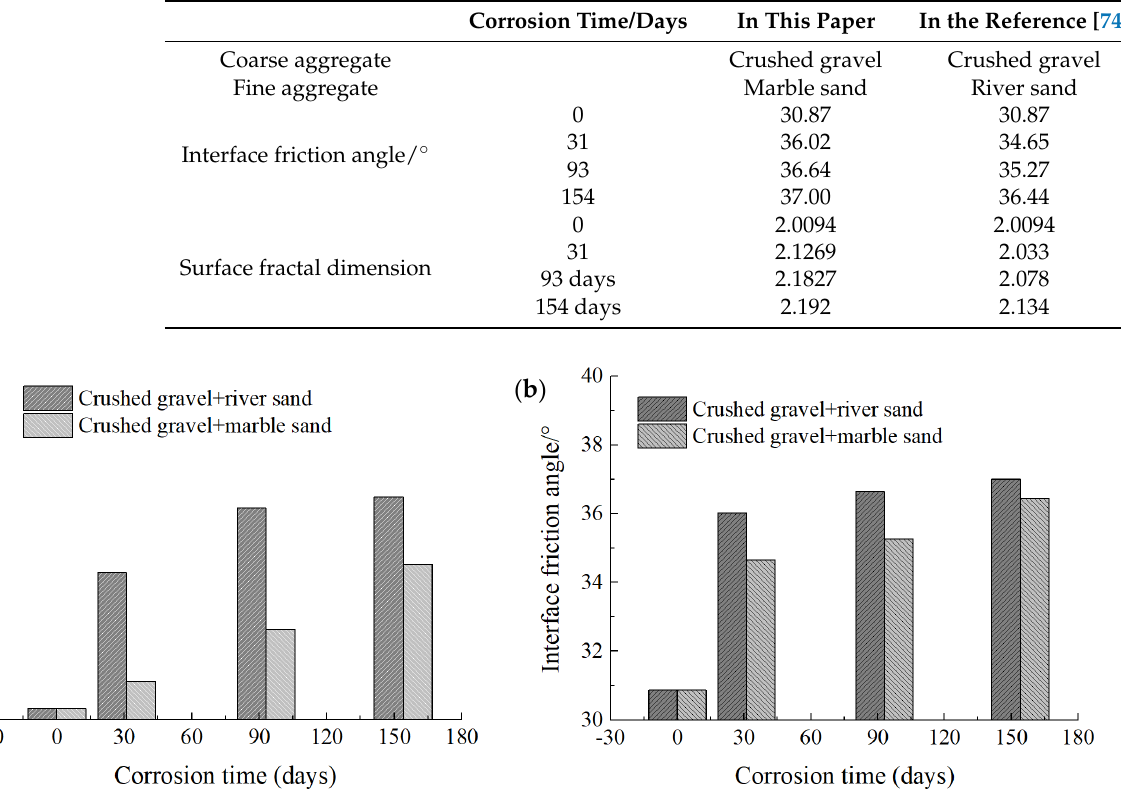
Figure 17. Comparison of the friction angle of the interface and fractal dimension between this paper and reference. ( a ) surface fractal dimension, ( b ) interface friction angle.